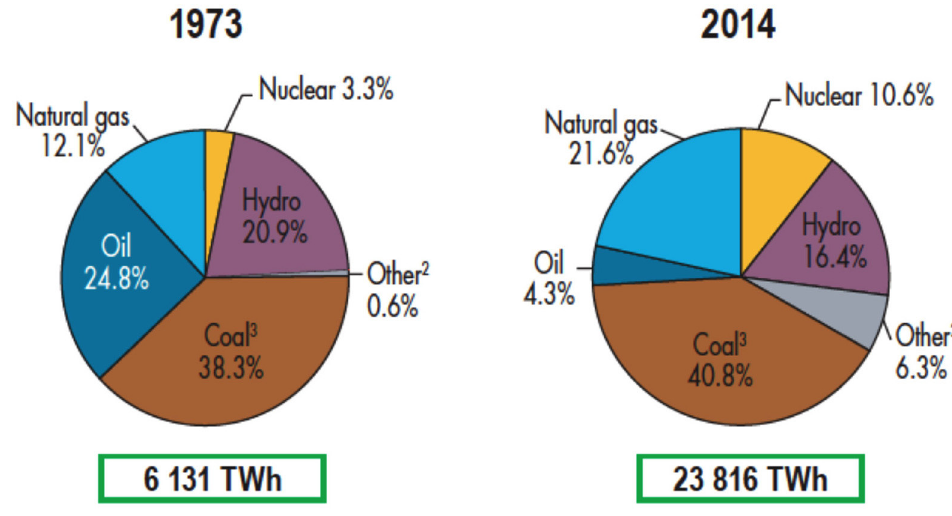
Fig. 6. – 1973 and 2014 fuel shares of electricity generation. (Courtesy of